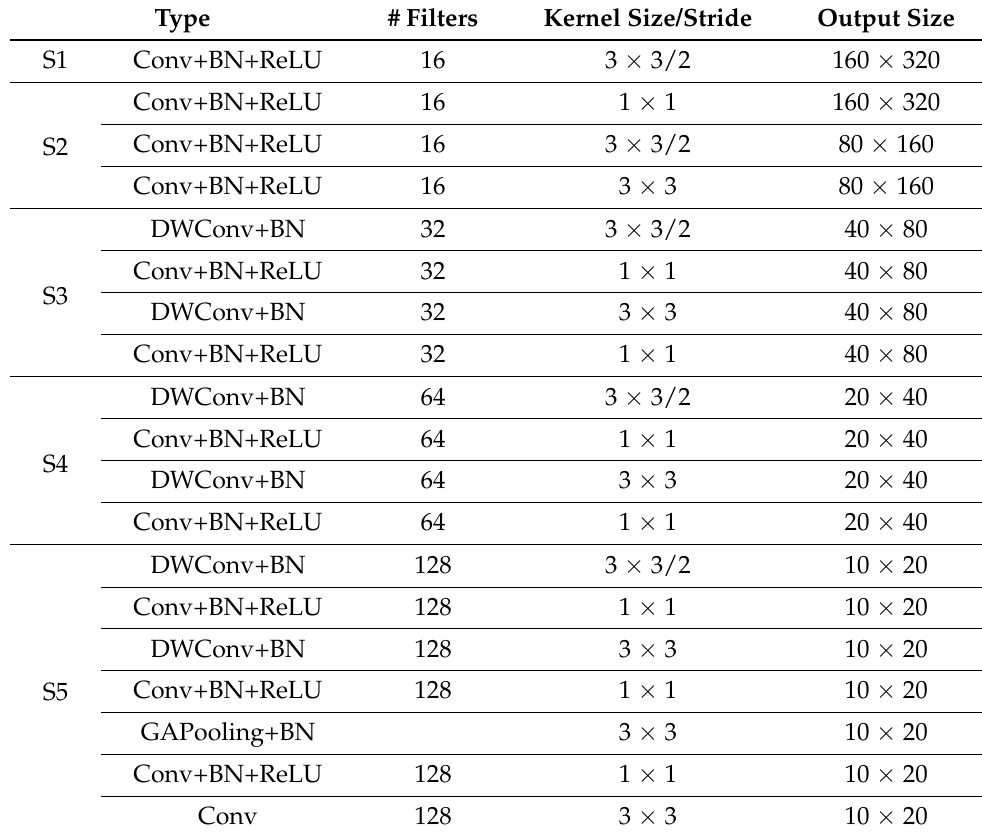
Figure 2. Overview of the RailNet architecture. From left to right, the model receives input images from a forward-looking camera and outputs binary segmentation images. The RailNet is mainly composed of two parts: the encoder and decoder. The detailed structural information of the network is shown in Table 1. SS refers to the Segmentation Soul section. Table 1. Details of the RailNet. The structure of the decoder is relatively simple, and there is a more detailed description in the text, so only the details of the encoder are shown in the table. The input size of the picture is 640 ×